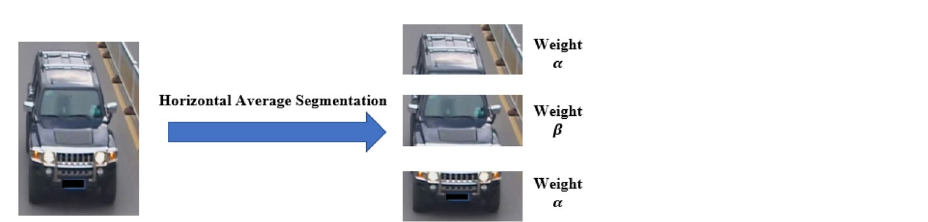
Figure 3. Multi-branch network architecture. GAP and 1*1 Conv refer to Global Average Pooling and 1*1 convolutional layer, respectively.